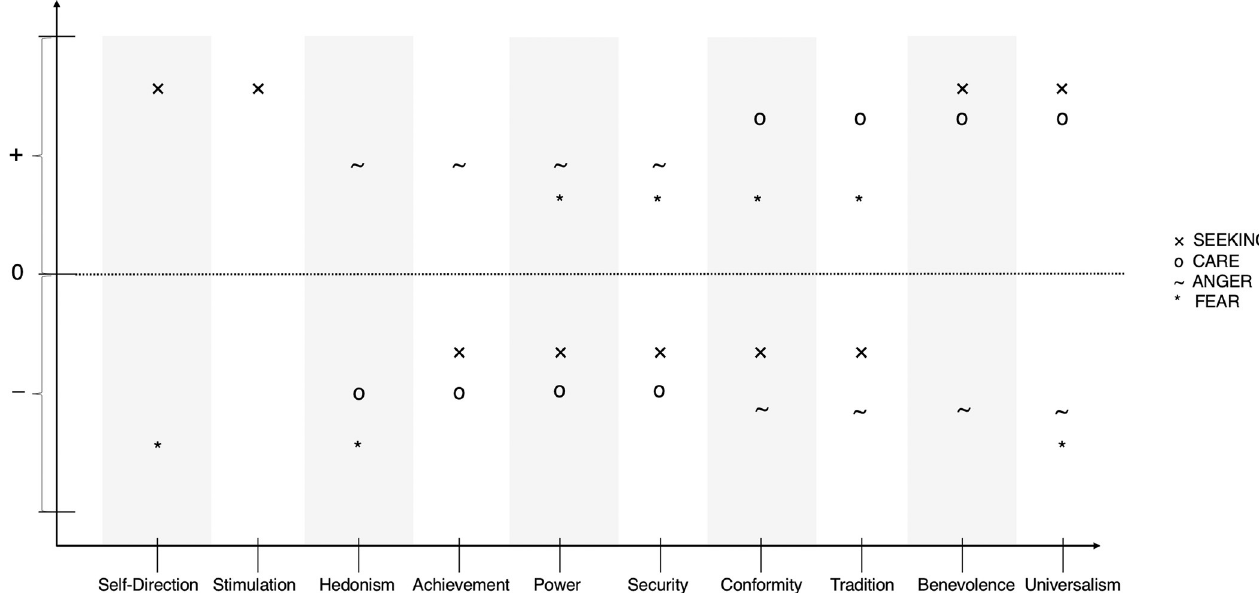
Fig 1. Graphical illustration of the ten value types according to Schwartz’ value theory on the x-axis and expected relations with the primary emotional traits (PETs) of SEEKING, CARE, ANGER, and FEAR on the y-axis. The upper half of the y-axis indicates positive and the lower half negative relations. Different positioning within the upper/lower half does not indicate different strengths of associations; we only formulate hypotheses on the direction of effects (positive versus negative) but not the strengths of effect sizes.